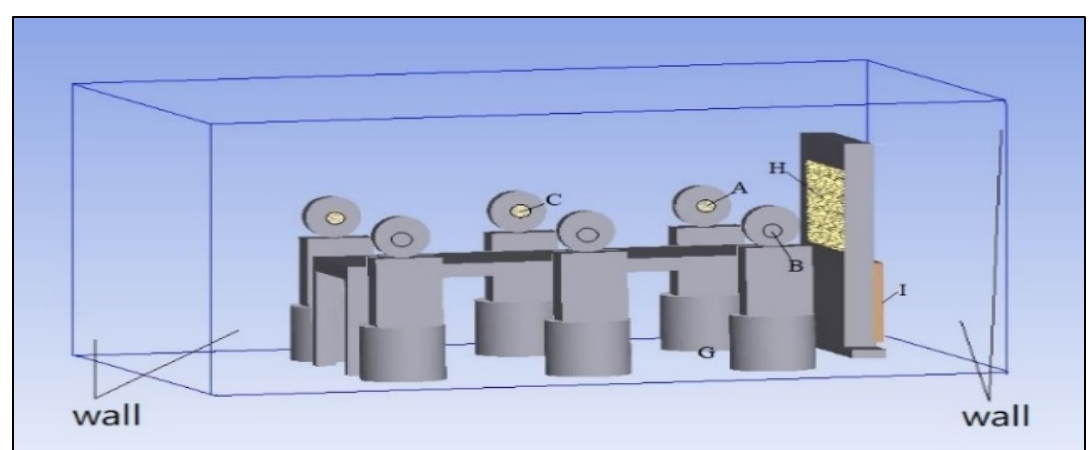
Figure 7. Air purifier in the conference room.